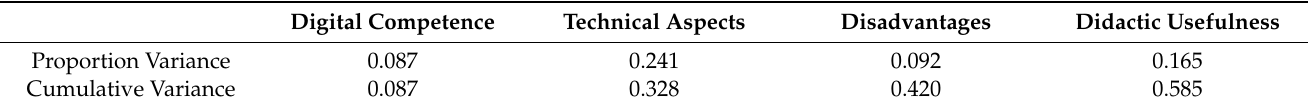
Table 4. Proportions of the variance explained by the defined subscales.